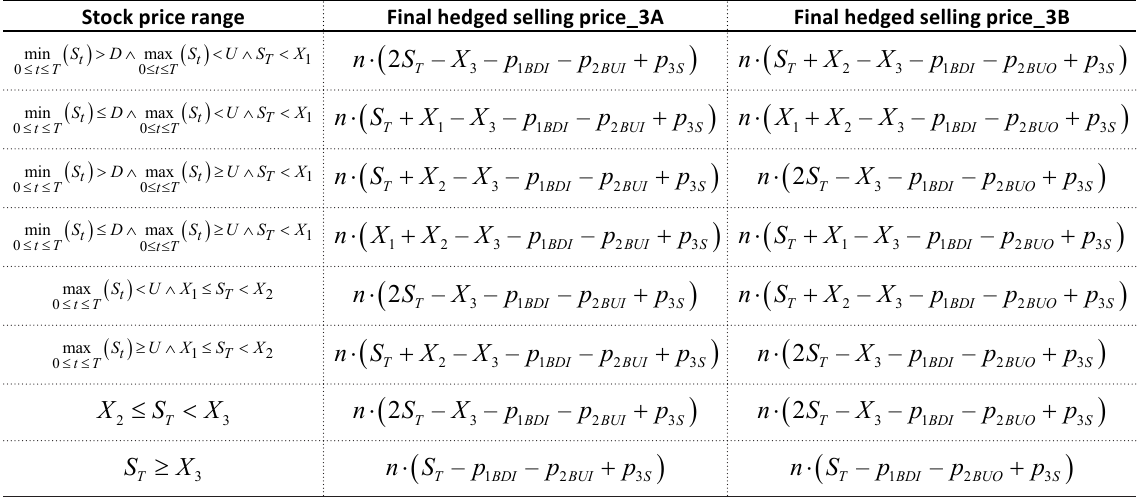
Table 4. Final hedged selling prices using Short Put Ladder option strategy_3